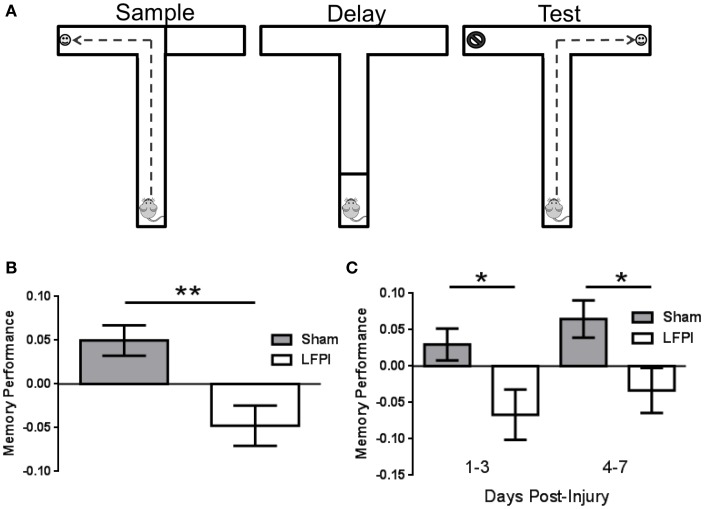
Persistent working memory impairment immediately following LFPI. (A) Schematic of the T-maze and the three phases of a trial. The sample phase exposes the animal to one arm to receive a food reward, then after the delay phase, the animal is exposed to both arms in the choice phase and must select the opposite arm in order to receive a food reward. (B) Memory Performance, as assessed by the delayed non-match to sample task, is impaired over the first 7 days after LFPI. (** indicates P < 0.001) (C) Memory Performance is impaired in both the first 3 days after LFPI as well as days four through seven after injury (* indicates P < 0.05).